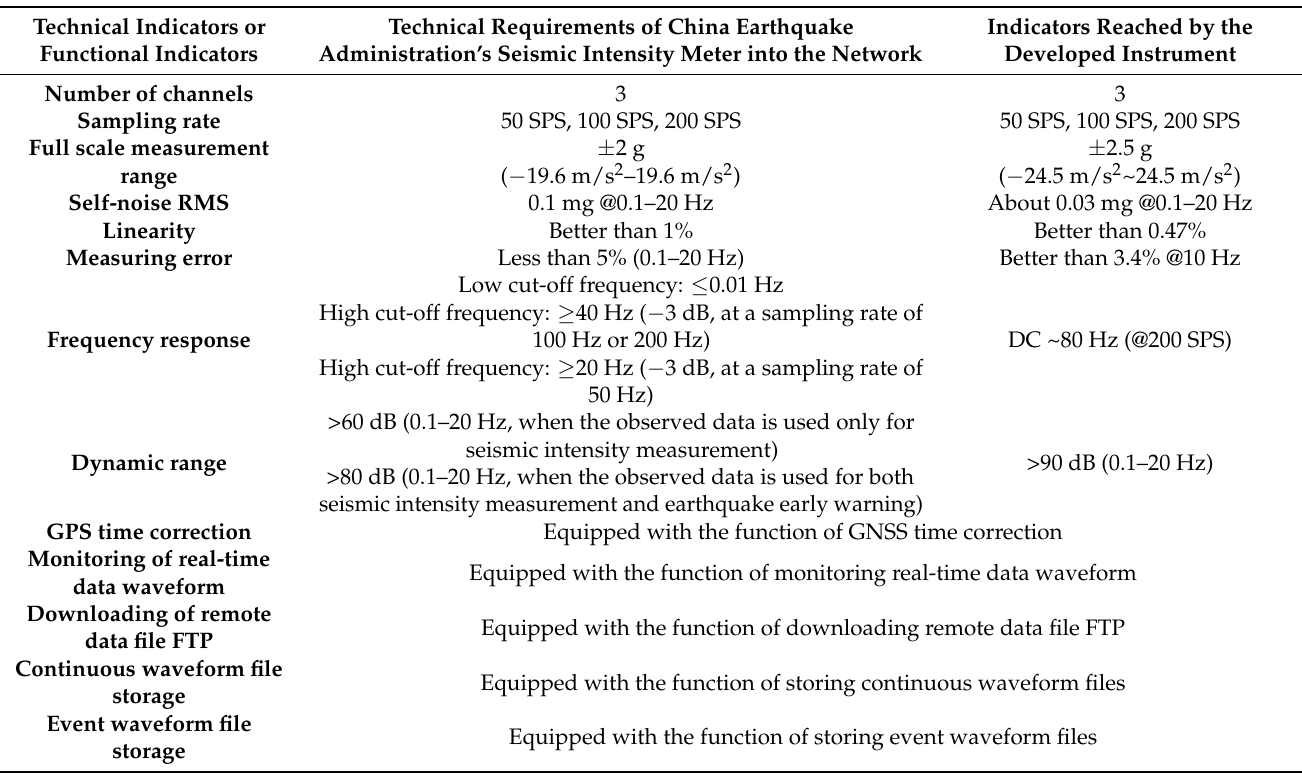
Table 2. Correlation average seismic sensor development index and China Earthquake Administration’s high-precision seismic intensity calculation standard.